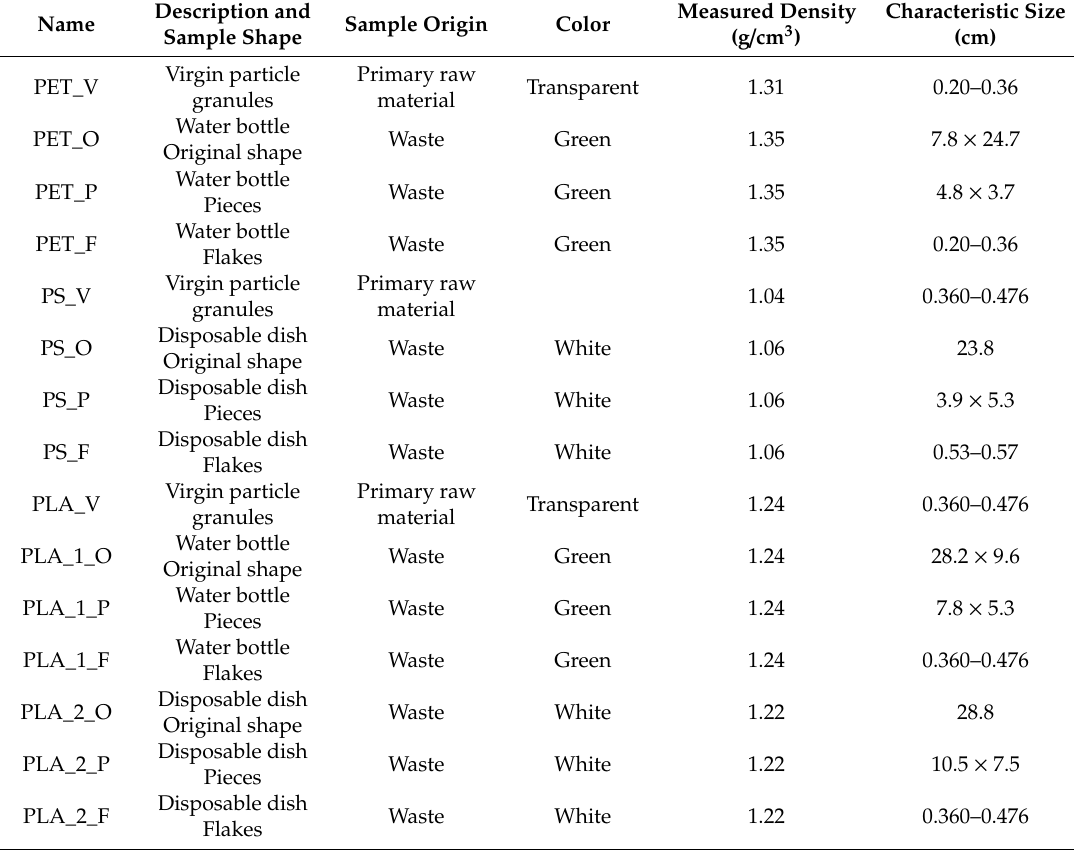
Table 1. Origin, shape, color, density and mean particle size of the samples